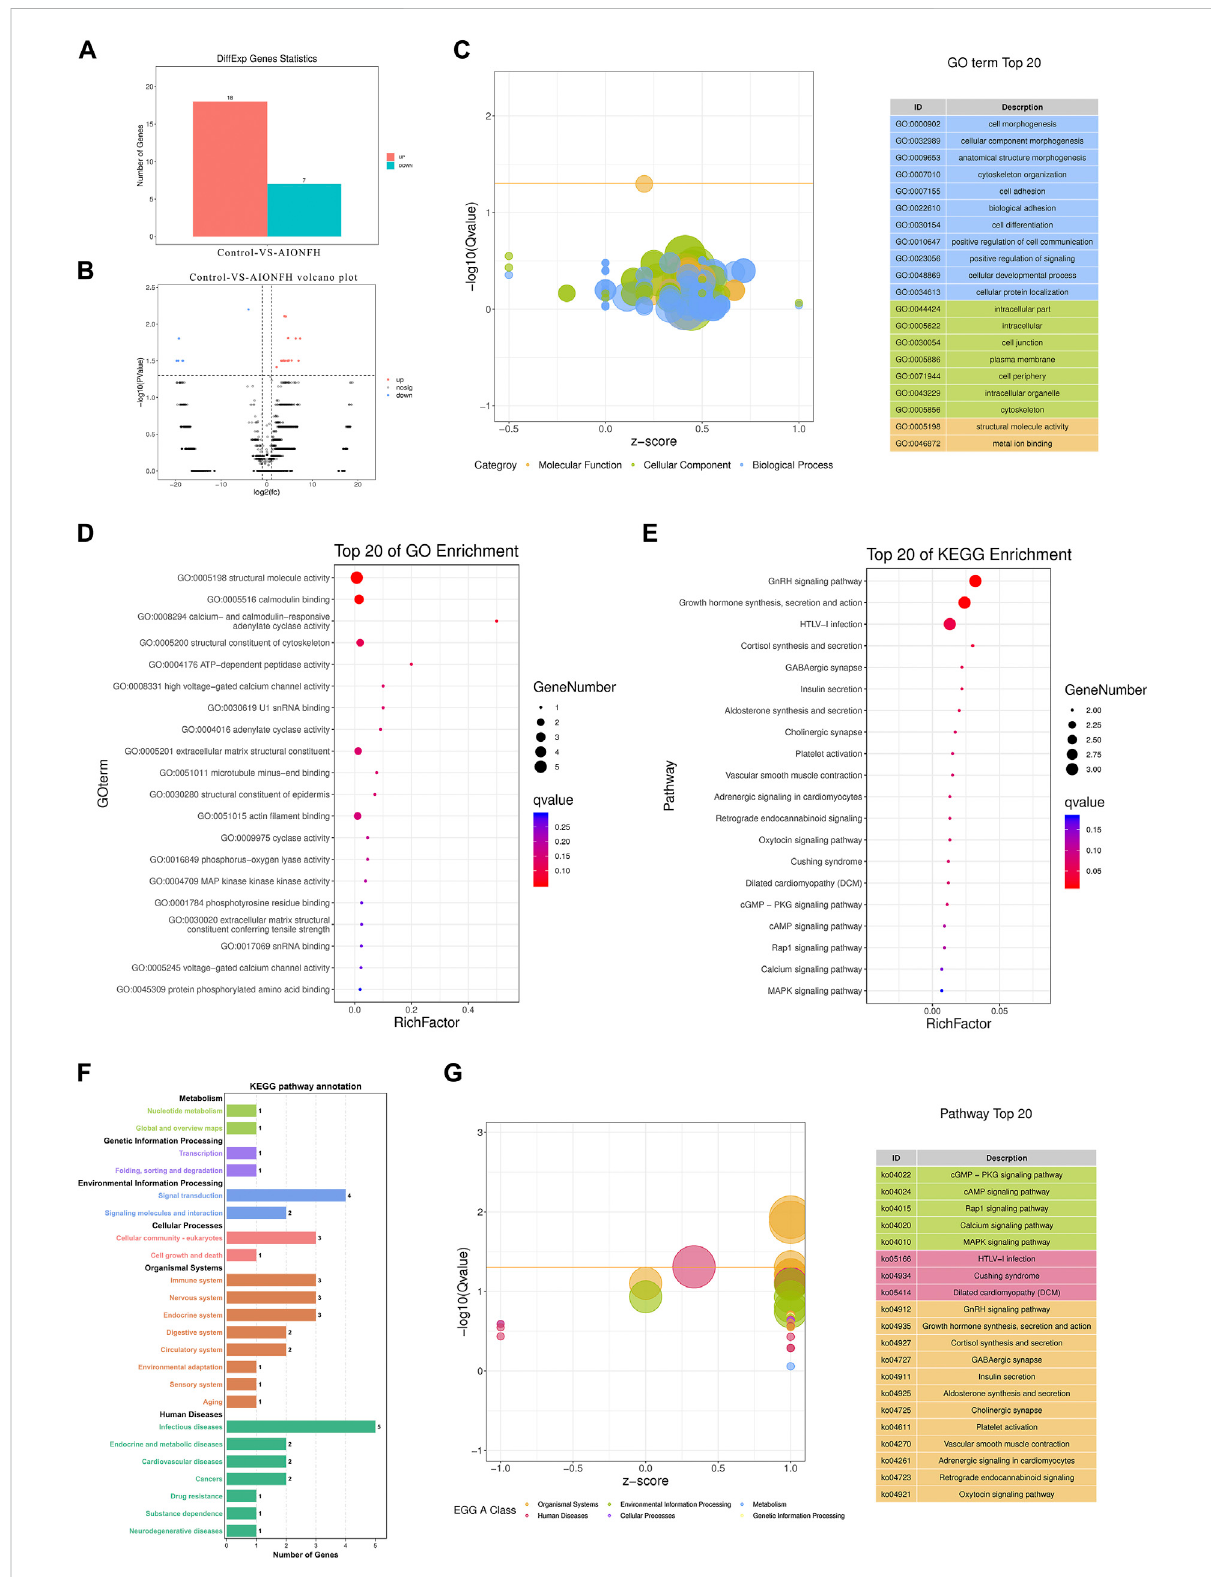
FIGURE 6 Bioinformatic analysis of exon region of gene in eccDNAs. (A) . Upregulated and downregulated eccDNAs related exon region genes. (B) . Volcanoplotshowsthedifferentgenes. (C,D) .GObiologicalprocessclassi fi cationofgenesandtop20ofGOtermsenrichedintheplotFigure (E – G) . KEGG function enrichment